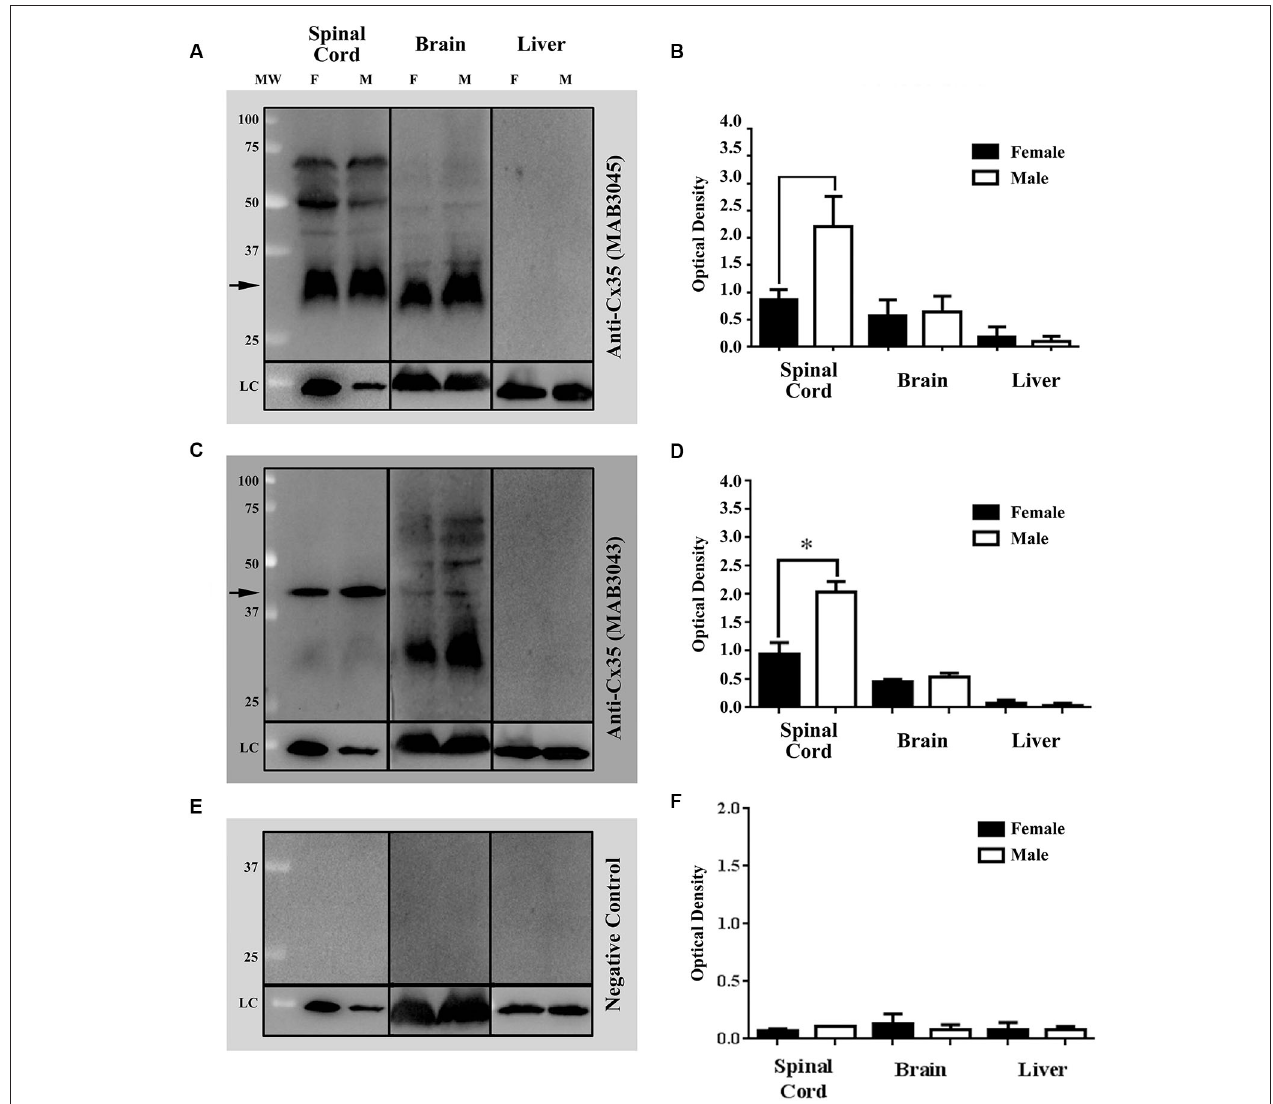
anti-mouse Poly-HRP antibody. The WB and densitometric analysis (see Figures 1E,F ) of this negative control validates the results of the commercially available mouse anti-Cx35/36 monoclonal antibodies by demonstrating that the specific bands recognized are not associated with a non-specific binding from the secondary antibody. OD at each protein concentration was averaged (3 blots), showing differences determined by using each potential loading control (anti-GAPDH or anti-acetylated-tubulin). Statistical differences were determined with student t -test analysis (* p < 0.05). Each lane contains 40 µ g of the extracted proteins from selected tissues homogenates of adult female and male Mosquitofish. The difference in the band intensity in the loading controls (LC) of the spinal cord tissue homogenate of male and female Mosquitofish could be interpreted as an issue in the total protein loaded in the WB (see Figures 1A,C,E ). However, the densitometric analysis (see Figures 1B,D,F ) demonstrates a difference between males and females.